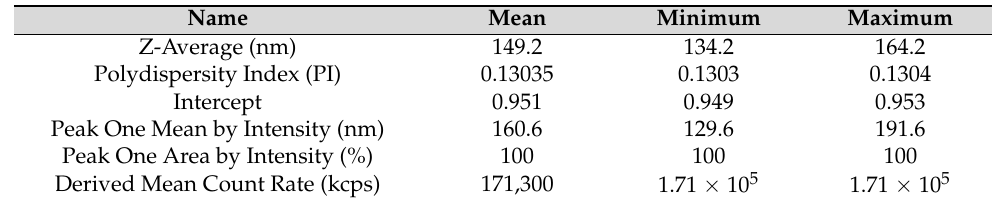
Table 1. Particle size distribution (PSD) by intensity statistics.